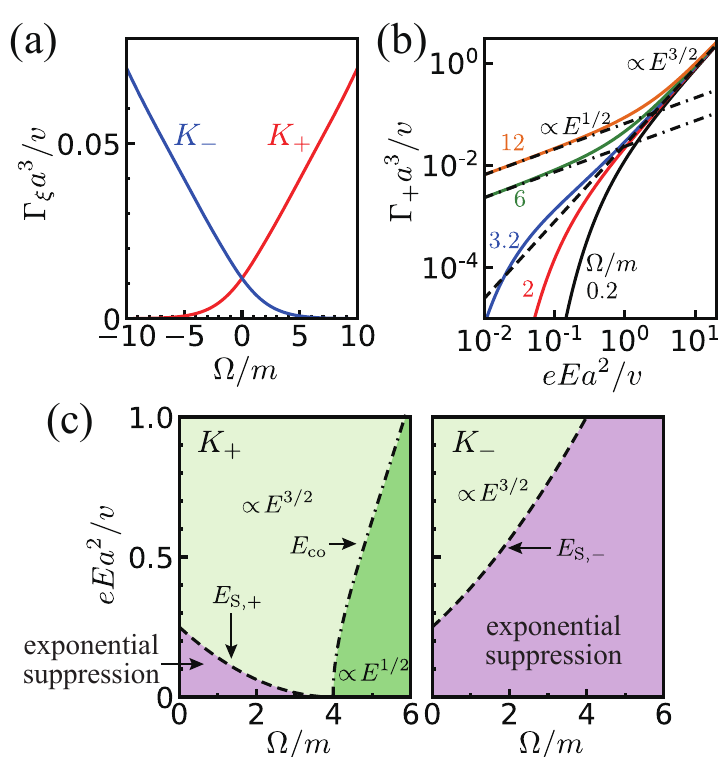
Figure 5: 2D gapped Dirac fermion: (a) The total pair production rate per unit of time and volume. We fix ma / v = 0.5 and eEa 2 / v = 1. (b) The electric field dependence of the total production rate P tot . (c) ( E , Ω ) -phase diagram of the twisted Schwinger ξ